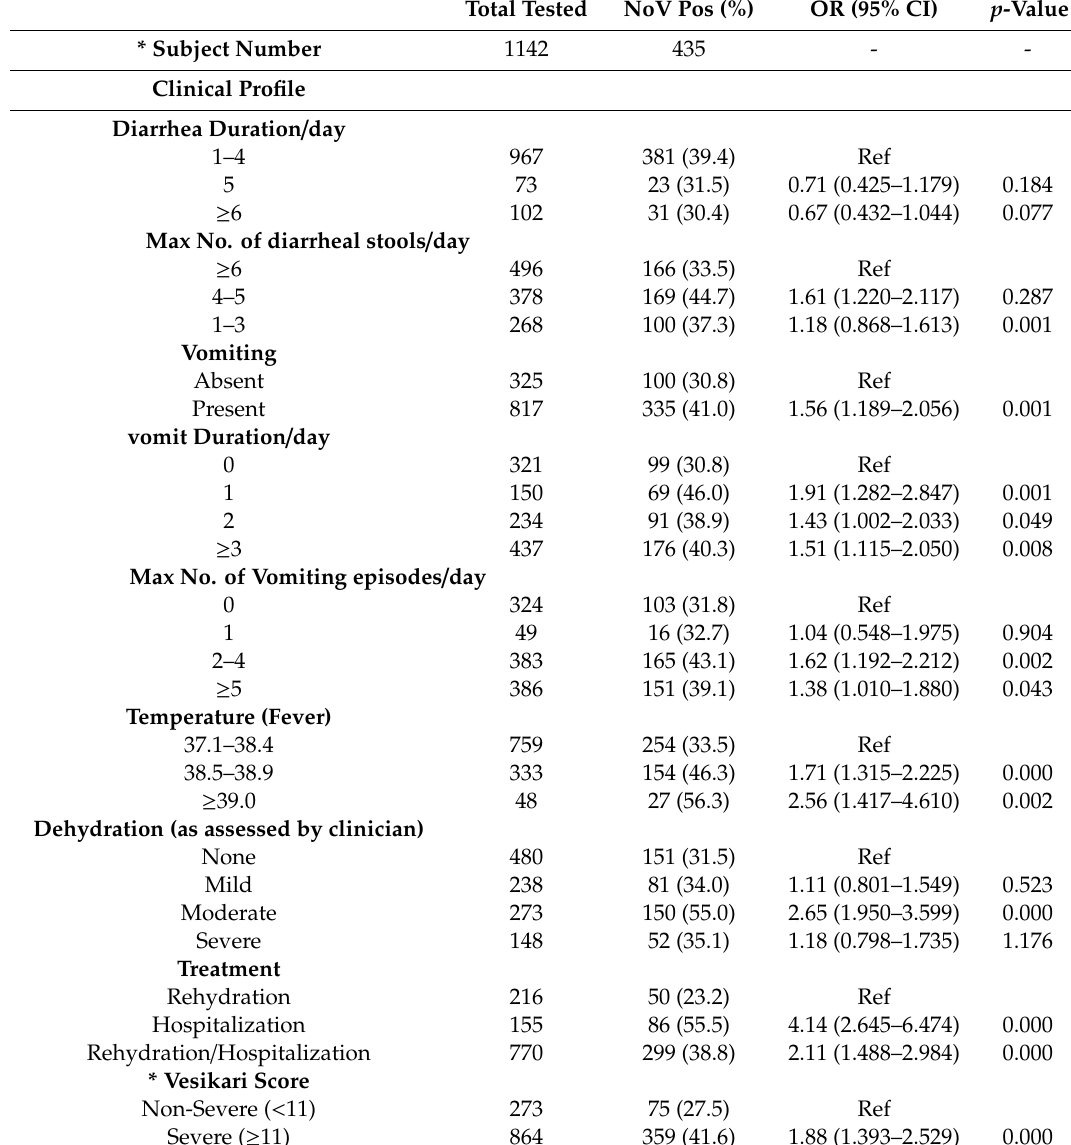
Table 1. Clinical Severity of AGE according to the norovirus infection status of study participants. Total Tested NoV Pos (%) OR (95%